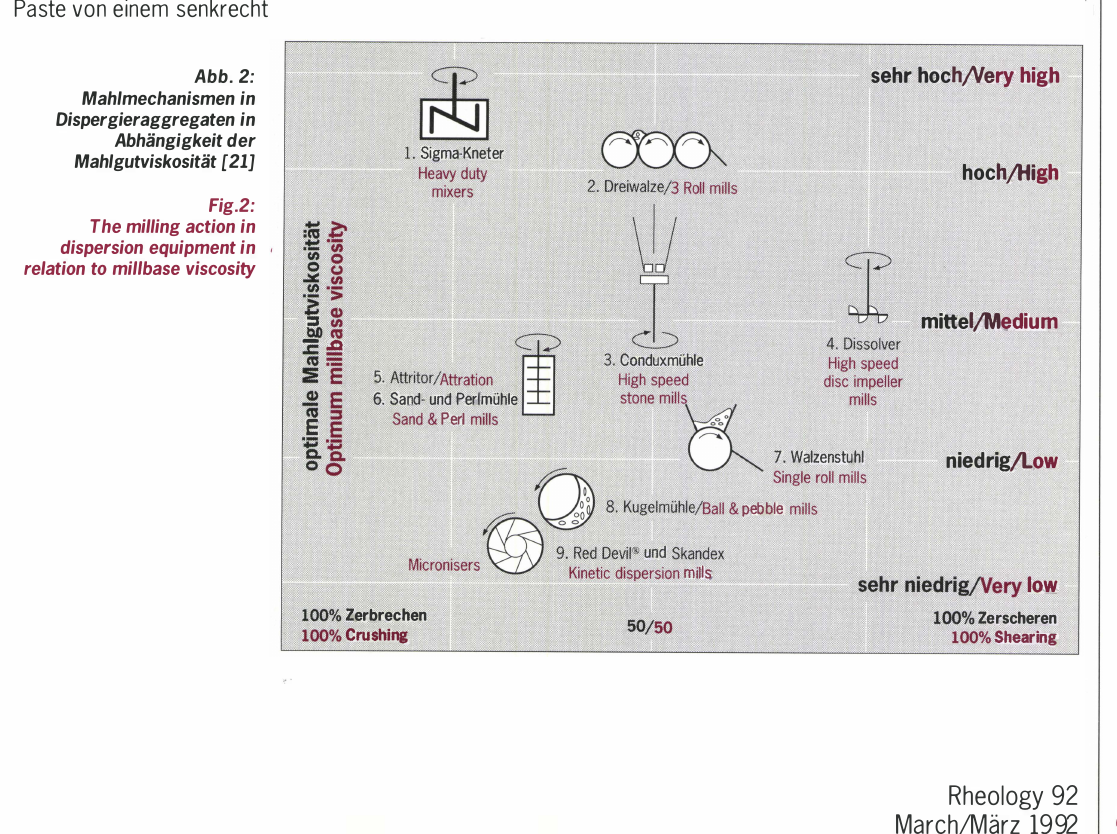
Fig.2: The milling action in dispersion equipment in :"tii� relation to mil/base viscosity - ·­.... "'